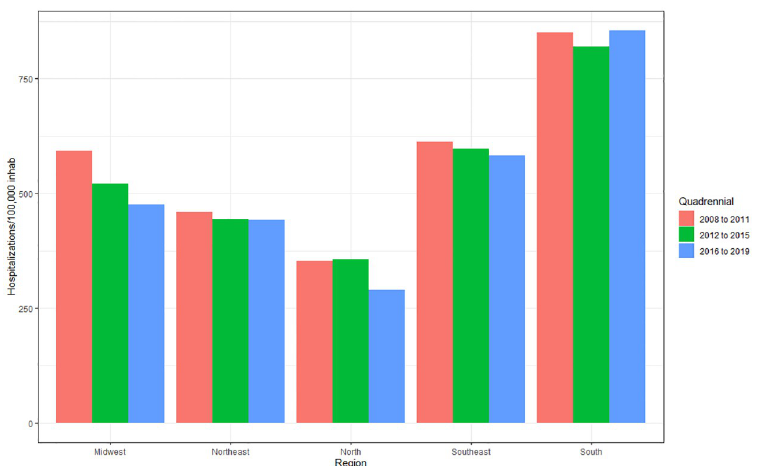
Fig 2. Average of hospital admissions caused by cardiovascular diseases per 100 thousand inhabitants according to region of residence and quadrennium (2008 to 2011; 2012 to 2015; 2016 to 2019). Source: Brazilian Institute of Geography and Statistics (IBGE) and Ministry of Health–Hospital Information System of the Unified Health System (SIH/SUS)